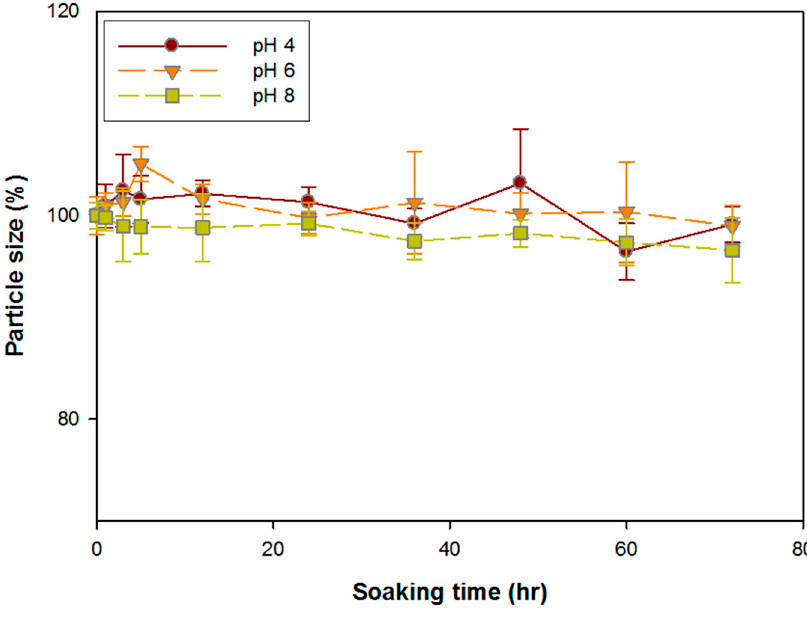
Figure 3. Stability characterization of DG/FA NPs. ( A ) The variation of particle size of DG/FA NPs soaked at 4, 25, 37, and 42 °C at different periods. ( B ) The variation of particle size of DG/FA NPs soaked in PBS of pH 4, 6, and 8 at different periods.